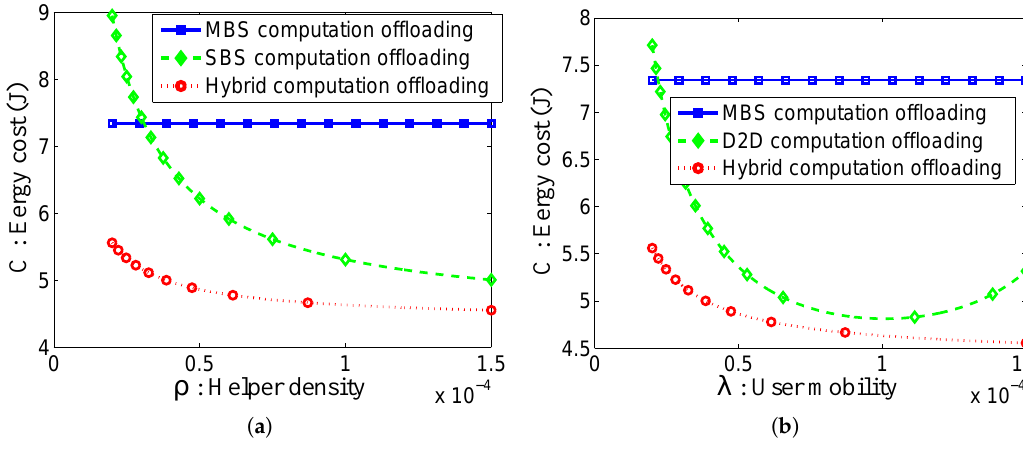
Figure 5. Illustration of the computation offloading energy cost. ( a ) Comparing the energy cost of MBS, SBS and hybrid computation offloading; ( b ) comparing the energy cost of MBS, D2D and hybrid computation